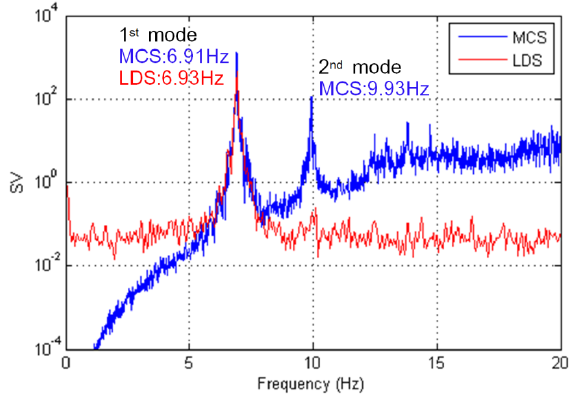
Figure 8. Extraction of the natural frequency.